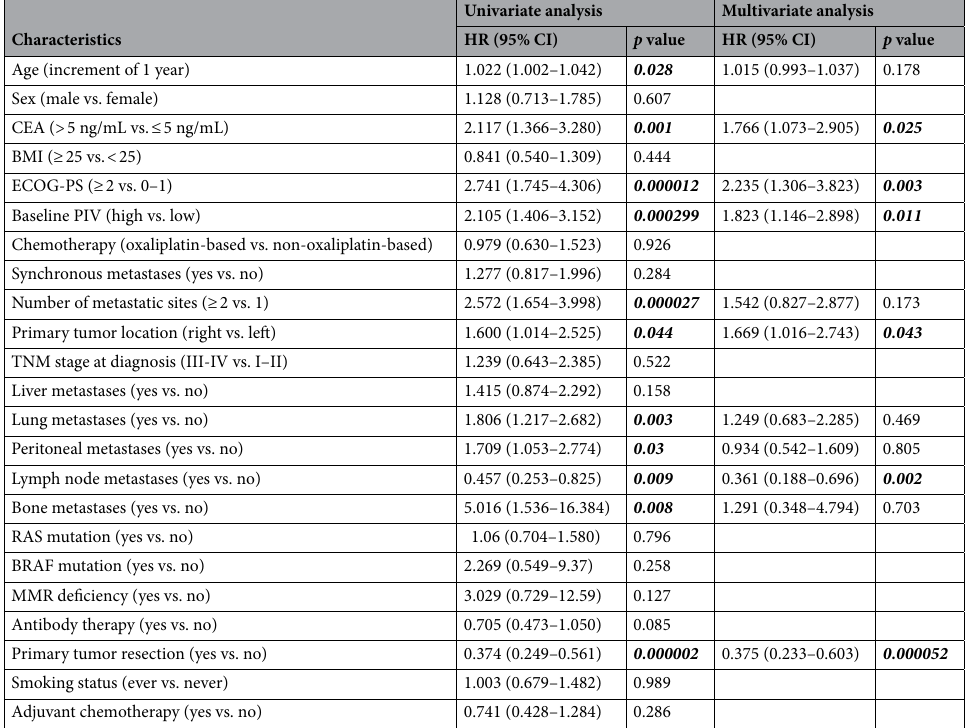
Table 2. Univariate and multivariate Cox regression analyses for overall survival. HR hazard ratio, CI confidence interval, CEA carcinoembryonic antigen, BMI body mass index, ECOG‑PS Eastern Cooperative Oncology Group Performance Status, PIV Pan-Immune-Inflammation Value. Bold italics numbers indicate statistically significant